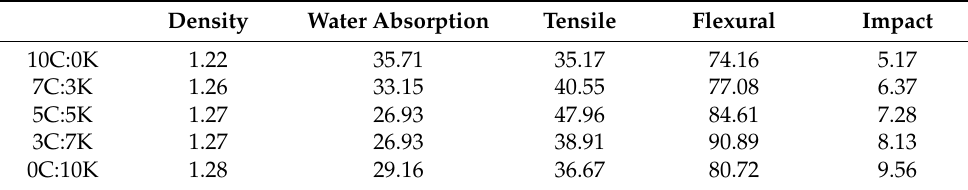
Table 6. Decision matrix.